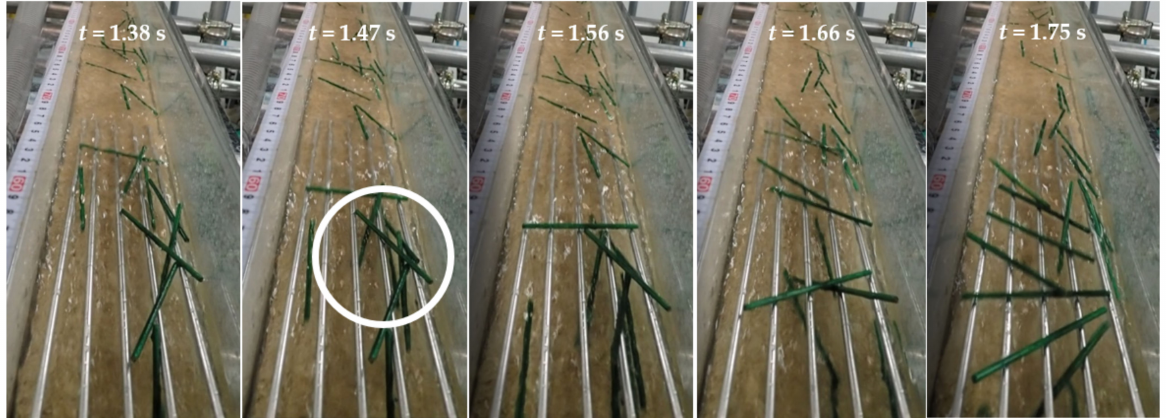
Figure 14. LW once scooped up by the rods (indicated by a white circle) relocate due to the flow and subsequent LW, and slip through the rods. (Experimental conditions are, 5 rods, n = 50, L w = 8 cm, and r w = 36 s − 1